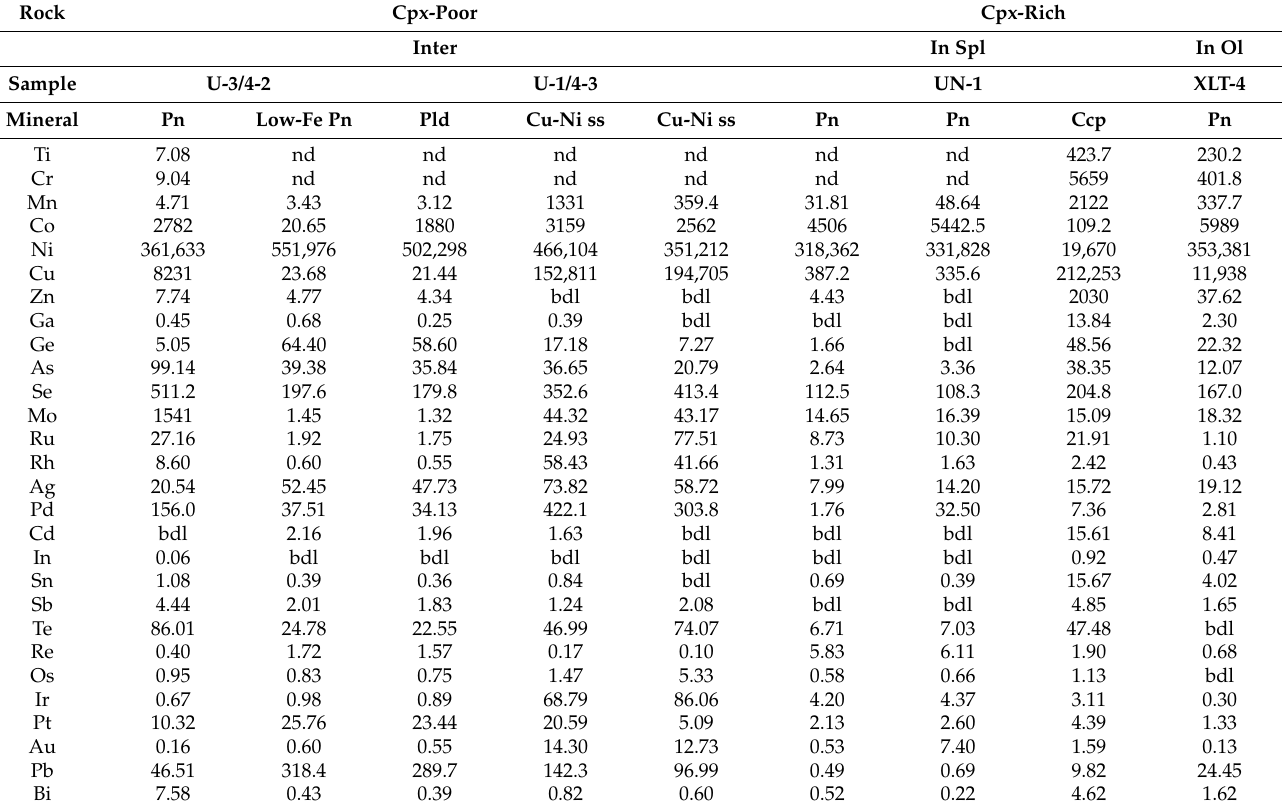
Table 5. Trace-element characteristics of monomineral BMS in lherzolites from East Antarctica (ppm).